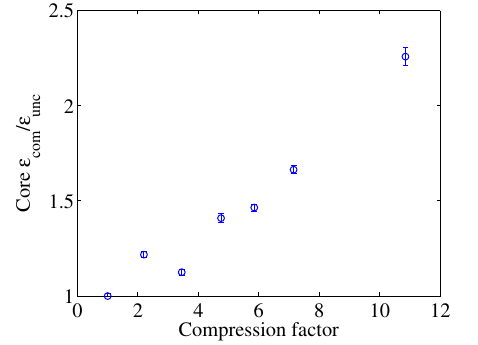
FIG. 5. Measured relative core emittance increase versus the dipole bending angle for a constant compression factor of 5.